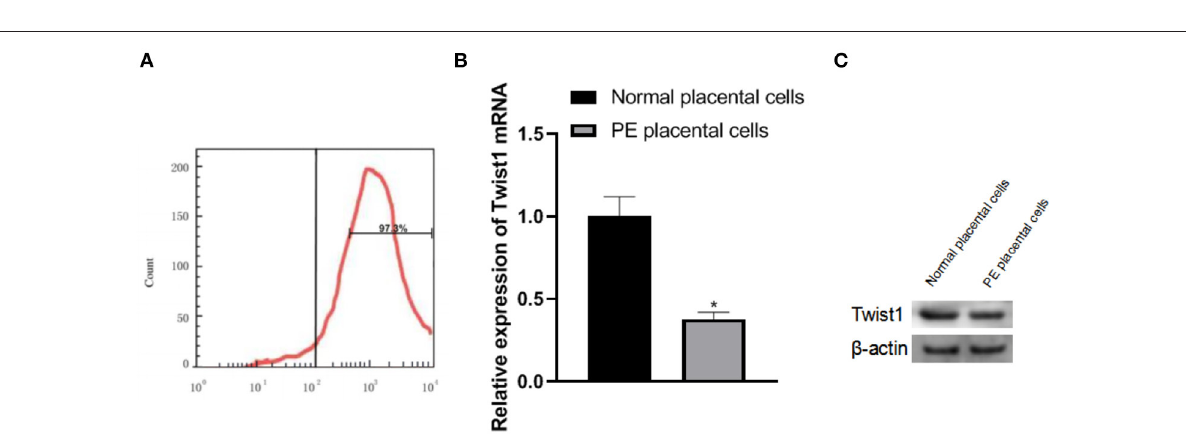
FIGURE 2 | Identification of primary trophoblast cells and the expression of Twist1 mRNA and protein in the cells. (A) Identification of Primary Trophoblasts; (B,C) The expression of Twist1 mRNA and protein; Compared with Normal placental cells, * p <